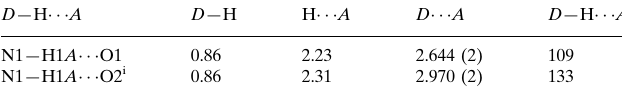
Hydrogen-bond geometry (A˚ , (cid:1)